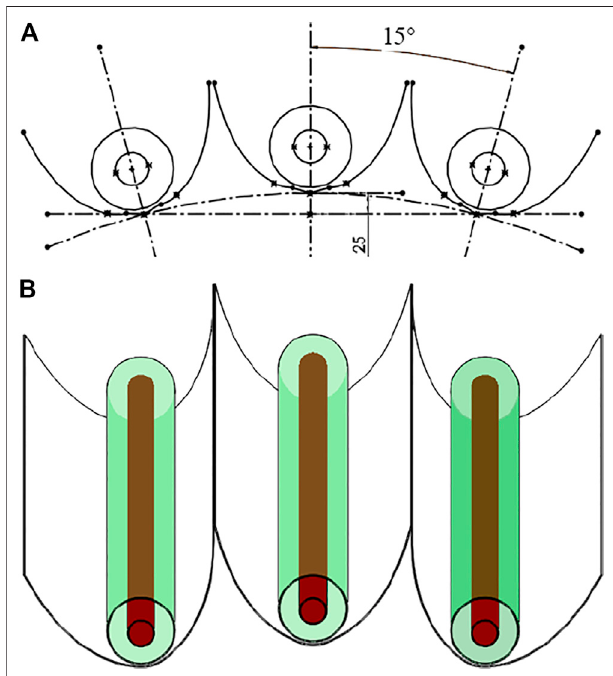
FIGURE 5 | Arrangement of CPC troughs in module (A) end view of troughs assembly, (B) isometric view of CAD model.